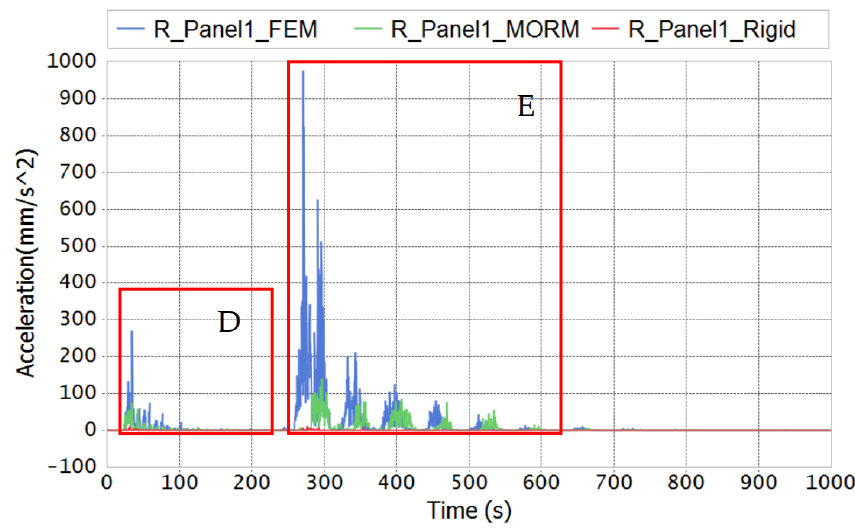
Figure 13. Accelerations of right Panel 1 in orbit steering by Rigid, MORM and FEM.